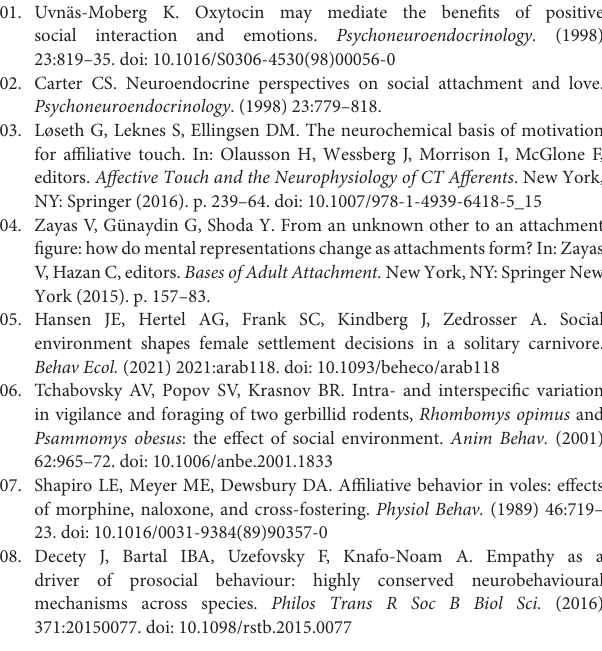
figure:howdomentalrepresentationschangeasattachmentsform?In:Zayas V,HazanC,editors. BasesofAdultAttachment.